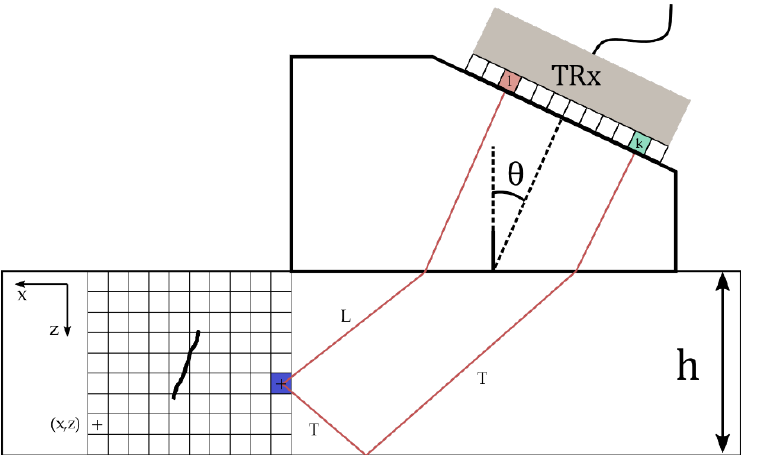
Figure 3. Data acquisition principle through full matrix capture (FMC): a signal is emitted by element i and received by element j . Image reconstruction area is divided into pixels, each one denoted by its position ( x , z ).